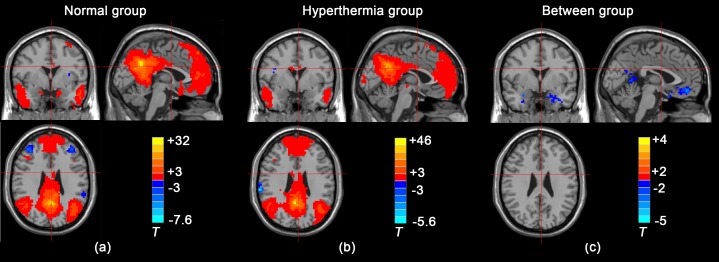
Maps of brain regions showing significant positive or negative correlations with the PCC/PCu in a voxel-wise manner of within-group analysis.(a) NC group, (b) HT group and between-group analysis (c).